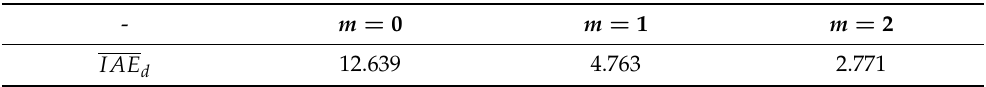
Table 2. Optimal normed IAE d = IAE d / ( K s T 2 responses for PID m from Table